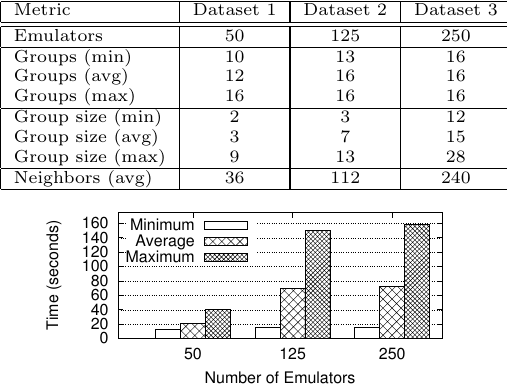
Figure 9: Emulator deployment time.